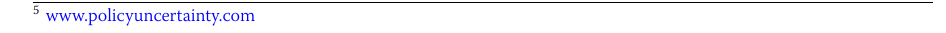
The asterisk * implies statistical significance at the 1% level. ADF and PP are abbreviations for the Augmented Dickey–Fuller test and Phillips–Perron test, respectively